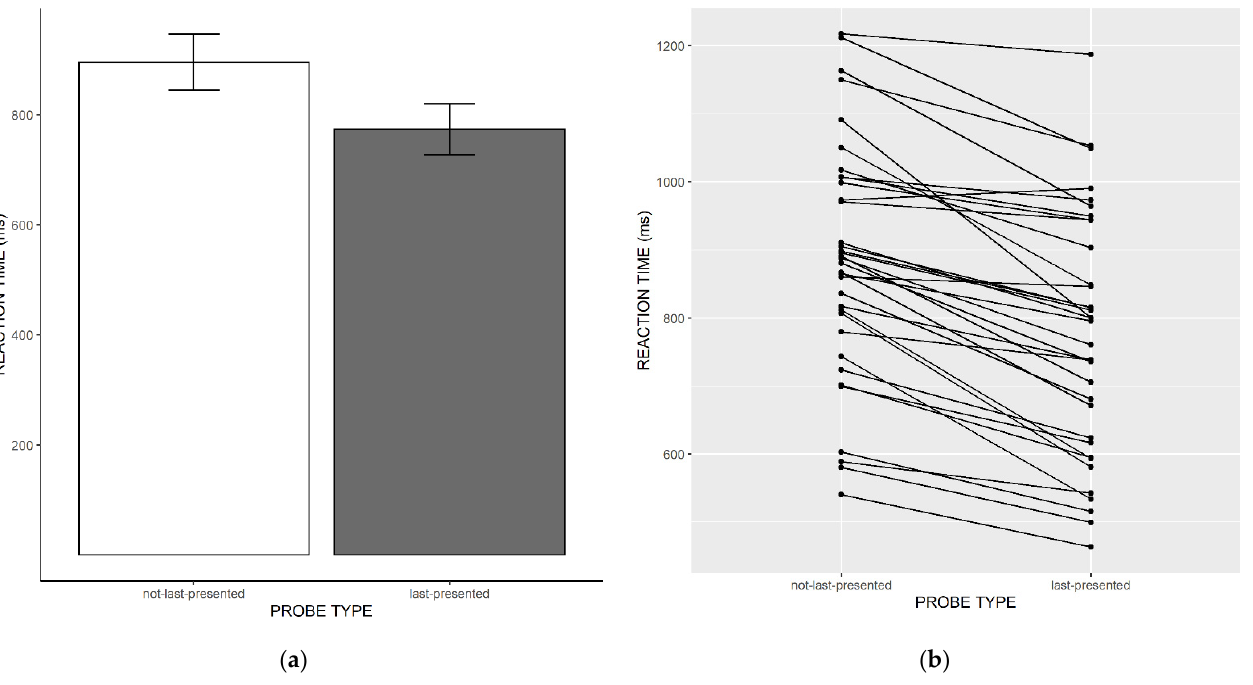
Figure 2. ( a ) Mean response times in ms for probes matching the last-presented item (“last-presented”) vs. probes matching other list items (“not-last-presented”). Error bars represent standard errors of the mean. ( b ) Individual mean response for probes matching the last-presented item (“last-presented”) vs. probes matching other list items (“not-last-presented”).